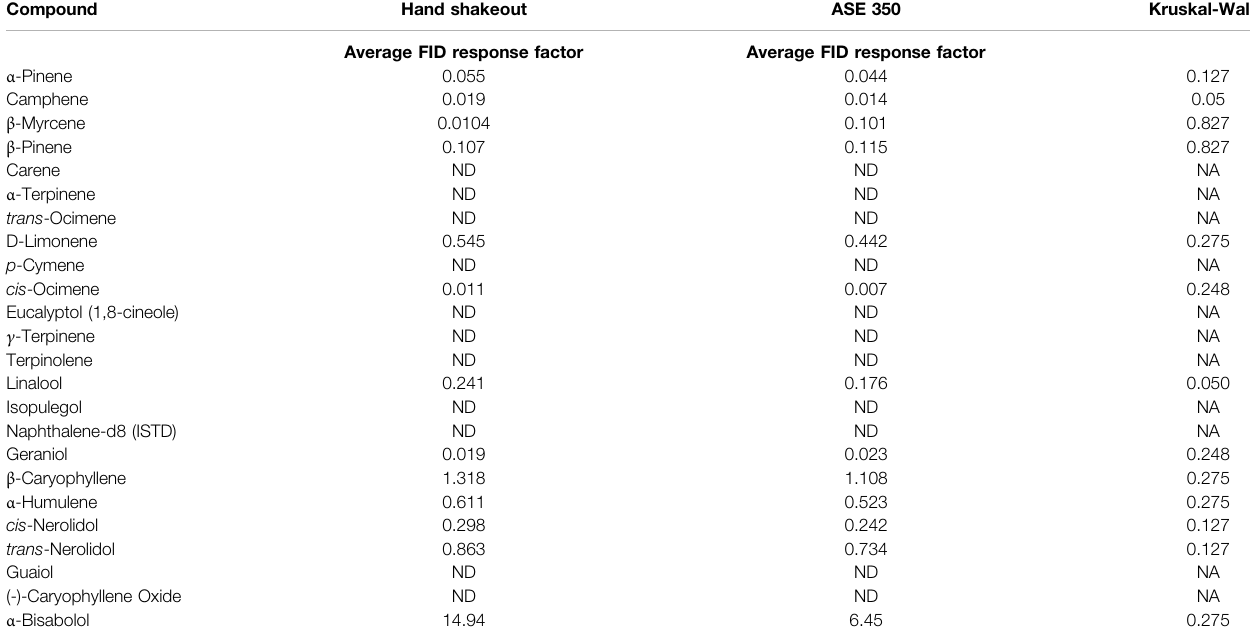
TABLE 4 | Hand shakeout vs. accelerated solvent extraction (ASE 350) for extraction of terpenes from cannabis fl ower.